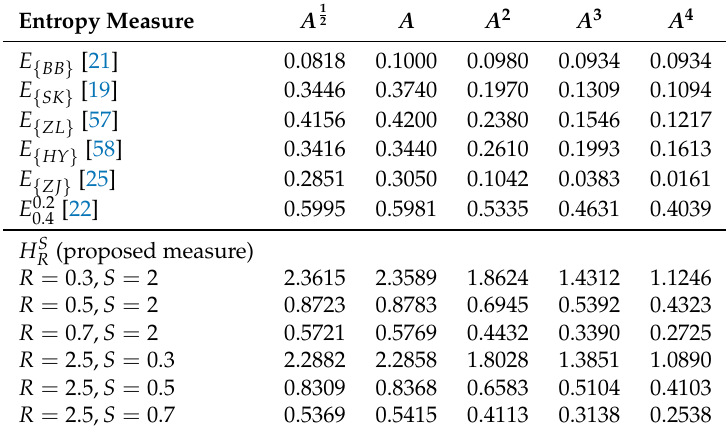
Table 1. Entropy measures values corresponding to existing approaches, as well as the proposed